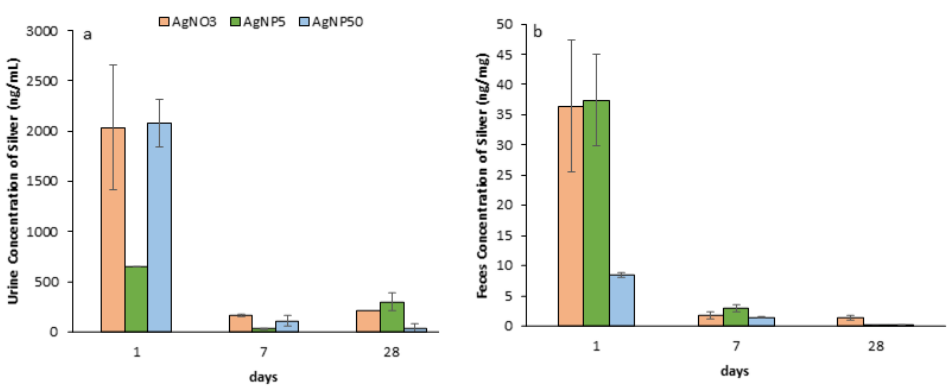
Figure 8. Excreted silver concentrations (ng/mL or ng/mg) during a 28-day recovery time after repeated intratracheal instillations of saline (control), AgNO 3 , AgNP5 and AgNP50. ( a ) Urine; ( b ) feces ( n = 4).